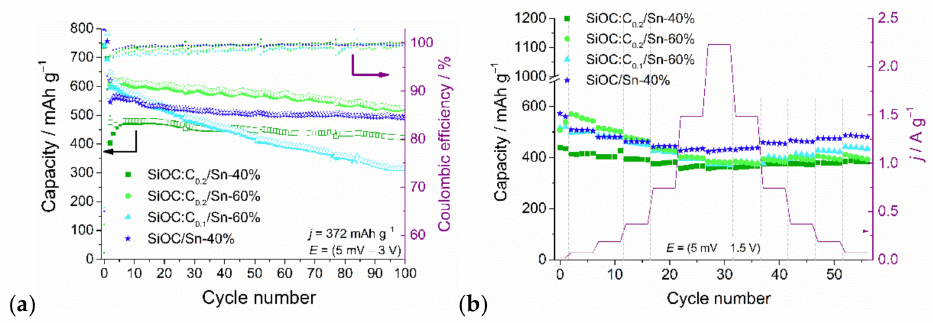
Figure 9. ( a ) Cycling stability at 372 mA g − 1 and the corresponding Coulombic efficiencies; ( b ) rate capability of the ternary SiOC/C/Sn